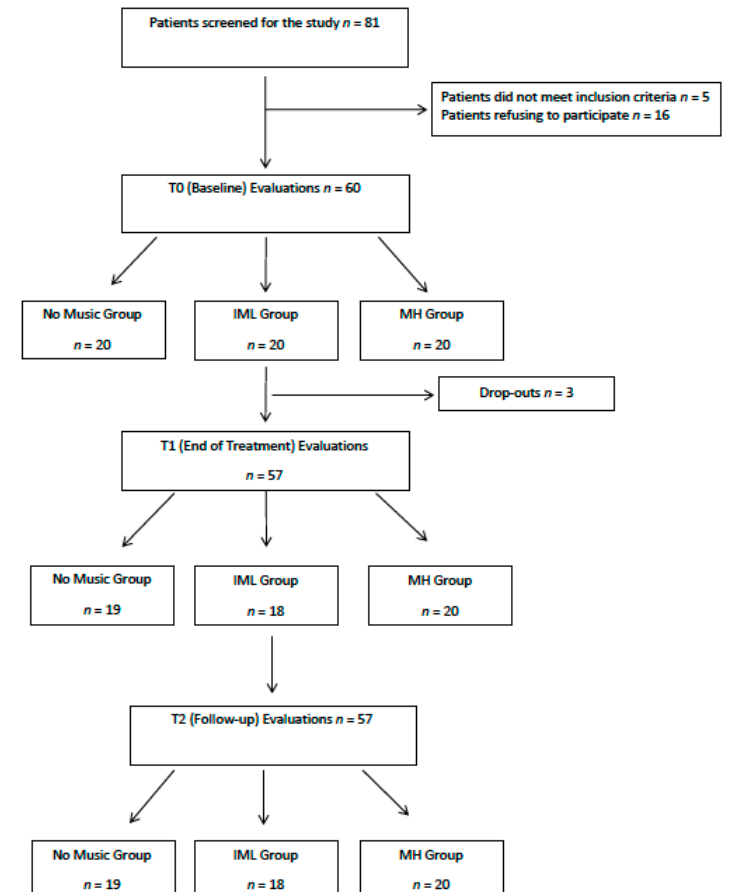
Figure 1. Distribution of patients and drop-outs in no music group, individualised music listening group (IML) and Melomics-Health group (MH) at screening, baseline (T0), end of treatment (T1) and follow-up (T2).